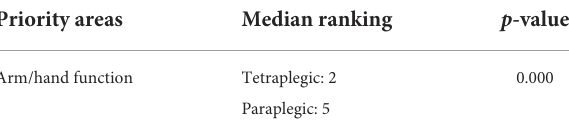
TABLE 3 Summary of statistical findings in priorities of functional recovery between tetraplegic and